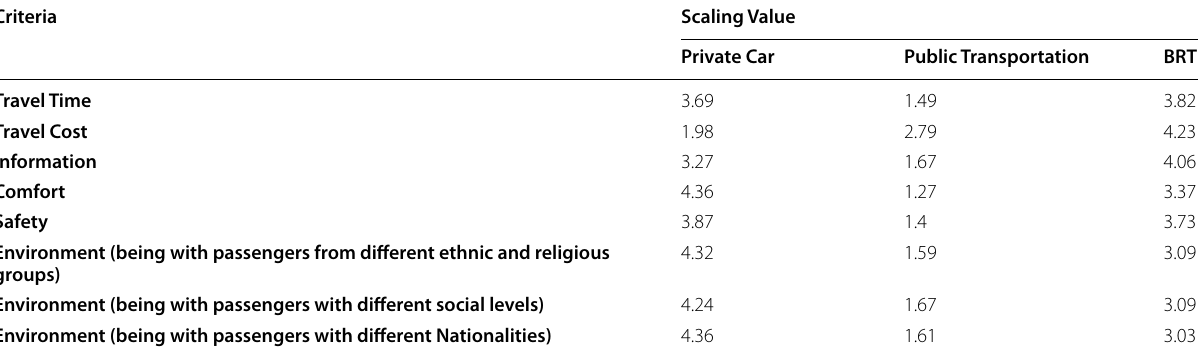
Table 3 Mean ranking of alternatives relatively to criteria